Question: Which kind of chart has been used to present this data?
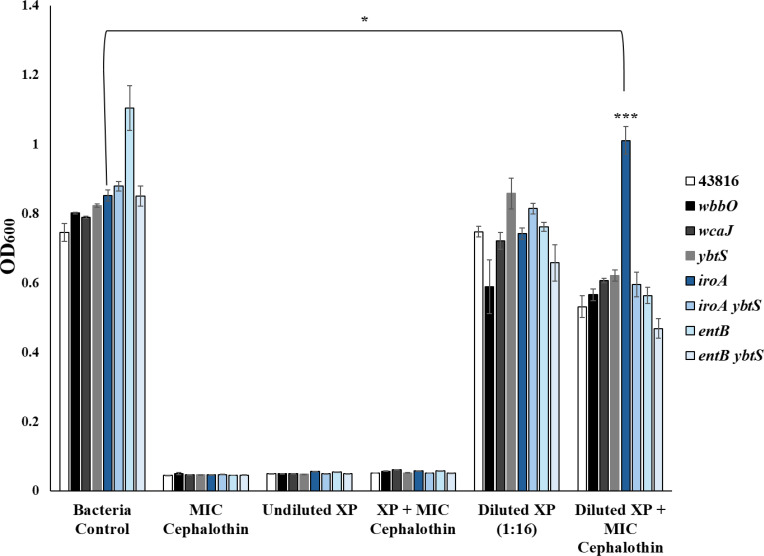
Answer: bar